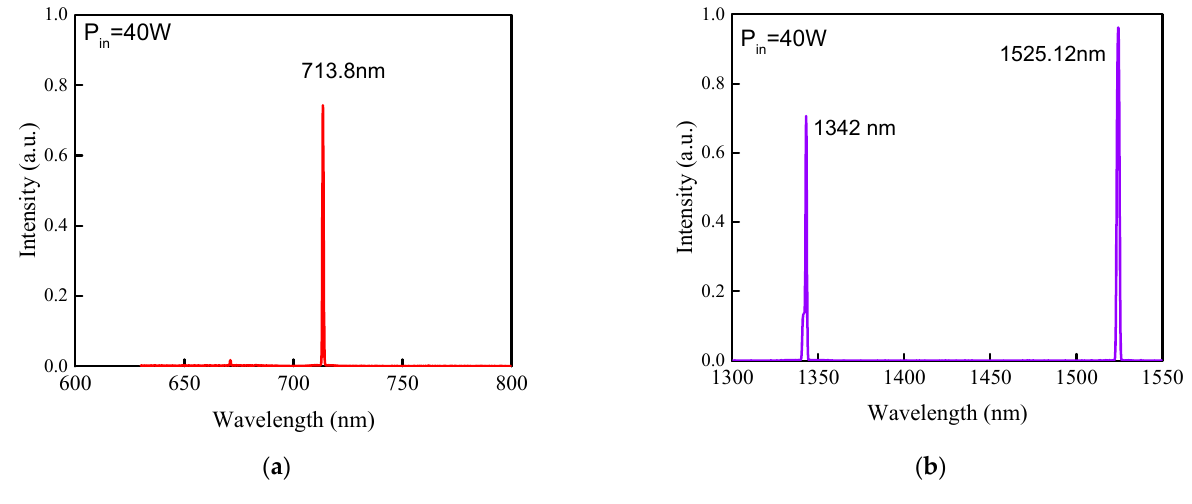
Figure 5. Experimental result for the optical spectrum of the output beam ( a ) SFG wave; ( b ) funda- mental and Raman